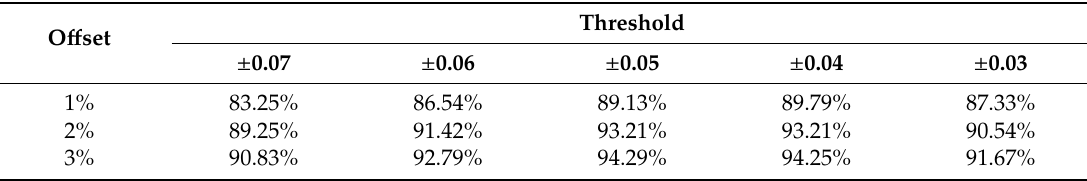
Table 5. Averaged detection probabilities of proposal 2 (window 1).